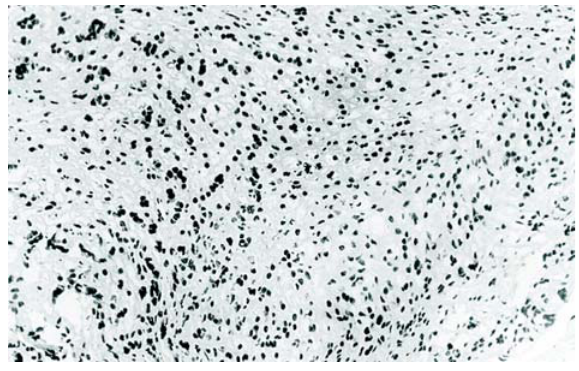
Figure 2 – Histologic section with lipid rich cortical cells clearly seen with no medullary tissue (HE, X150).